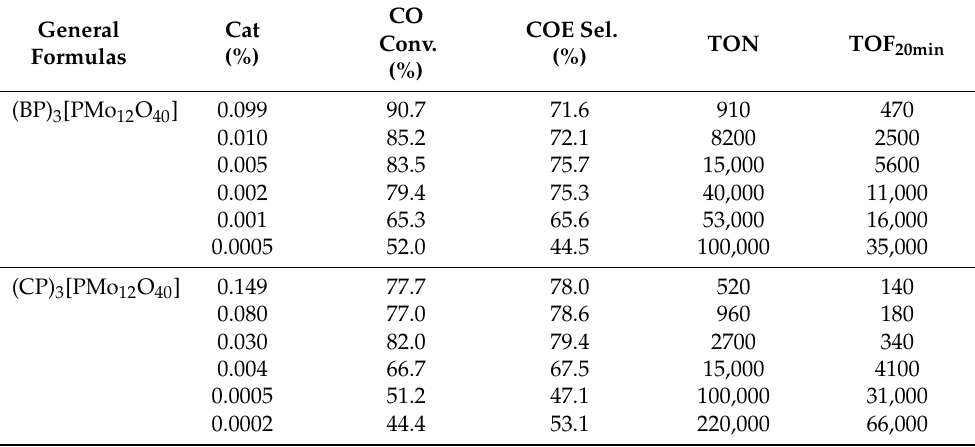
Table 11. CO epoxidation under organic solvent free conditions with organic salts of POMs from Figure 22. TBHP/cyclooctene = 1.5, 24 h, 80 ◦